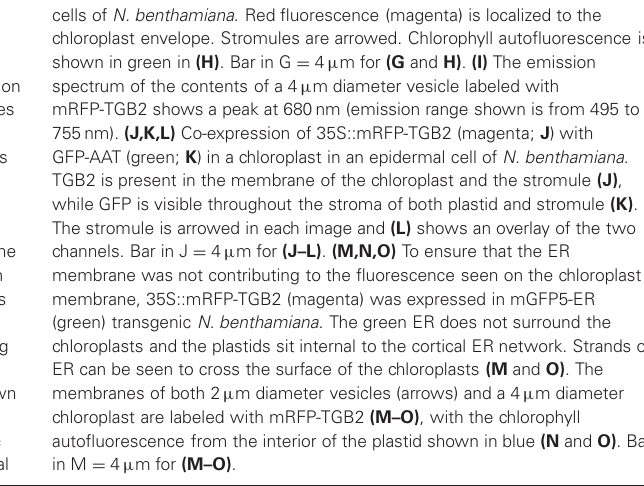
FIGURE 2 | Transient expression of TGB2 protein in epidermal cells. (A) Expression of sg::mRFP-TGB2 (magenta) from a PMTV vector in epidermal cells of N. benthamiana. Fluorescence is first visible throughout the ER network (typically 1 dpi). Bar = 10 μ m. (B) Slightly later in the infection process (typically 2 dpi) than seen in (A) , mRFP-TGB2 labels the membranes of small mobile vesicles that are 2 μ m in diameter (arrows). Bar = 10 μ m. (C) Expression of PMTV reporter clone PMTV3.YFP-TGB1 in epidermal cells of N. benthamiana at 2dpi; YFP fluorescence (green) is seen throughout a small lesion consisting of ∼ 12 cells. Bar = 50 μ m. (D) Expression of PMTV reporter clone PMTV3.YFP-TGB1 (cid:2) TGB2 in epidermal cells of N. benthamiana . In the absence of a functional TGB2, the viral reporter clone (YFP fluorescence) is confined to a single cell. Bar = 20 μ m. (E) Expression of PMTV reporter clone PMTV3.YFP-TGB1 (cid:2) TGB2 (green) in epidermal cells of N. benthamiana that are expressing 35S::mRFP-TGB2 (magenta); YFP fluorescence has spread out of the initial cell (marked with ∗ ) to surrounding cells; YFP can be seen in the cytosol and accumulated in the nuclei of neighboring cells. Bar = 10 μ m. (F) Enlarged portion of the YFP signal shown in (E) to show the movement of the fluorescence out of the initial cell, and the accumulation of this YFP in nuclei of neighboring cells (arrowed). Bar = 10 μ m. (G,H) Expression of sg::mRFP-TGB2 from PMTV vector in epidermal